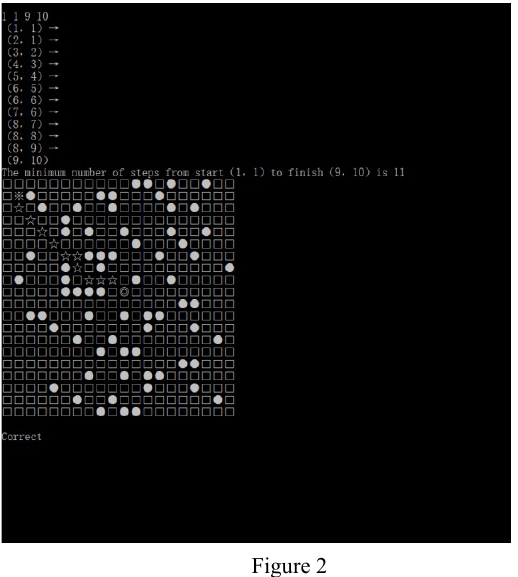
When the 3D path planning algorithm is applied to the